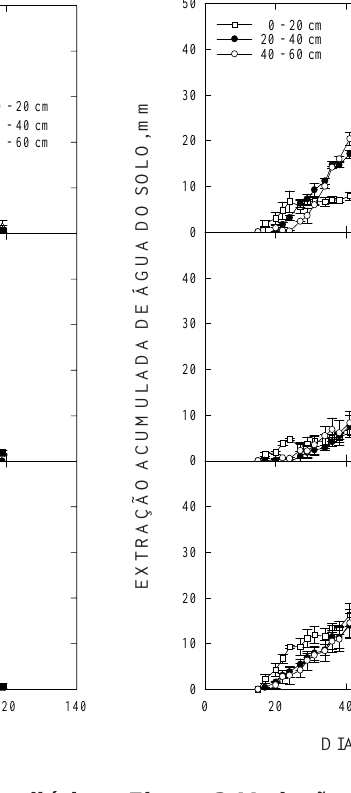
Figura 2. Variação dos valores médios da extração acumulada de água pelas plantas de milho submetidas a déficit hídrico terminal em cada profundidade do solo em três solos de diferentes texturas. As barras verticais representam o